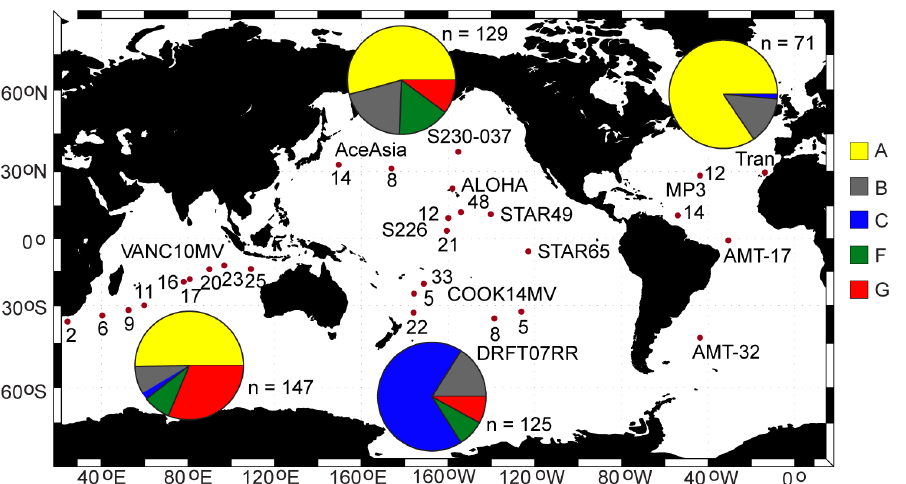
Figure 1. Distribution of sampling locations (red circles) and the frequency of individuals from different genetic clades in the Atlantic, Pacific, and Indian Oceans (pie charts), based on gDNA amplifications of mtCOII. Total sample sizes (n) for each ocean region are given next to the pie charts. Clade colors are defined in figure 2. The cruise and station number for sample sites are listed next to the symbols (detail in Table 1).